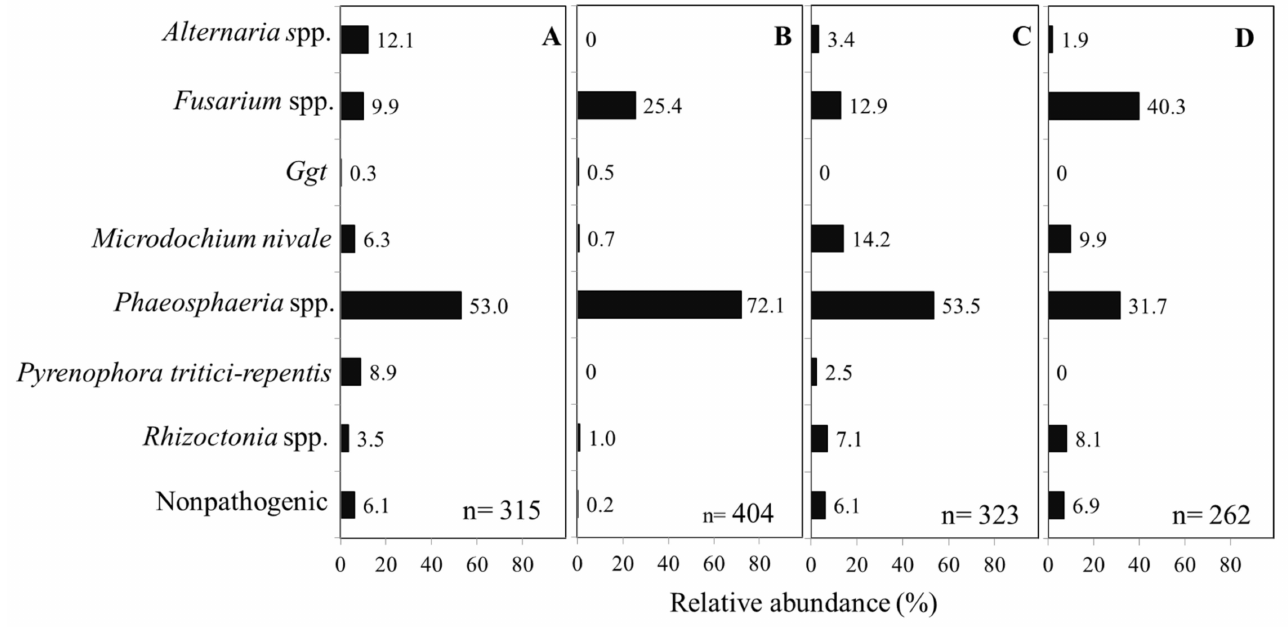
Figure 1. Relative abundance (%) of the fungal species isolated from the first internode of wheat culms on 20% acid PDA obtained from four intensively sampled fields in southern Chile during the grain-filling period: (( A ): Potrero 11-Perquenco, ( B ): El Ret é n-Osorno, ( C ): Potrero 13-Perquenco, and ( D ): Caj ó n-Temuco). N = total isolates obtained from 24 sampling points collected by field. In each sampling point, 20 culms were selected to be analyzed. A sampling point corresponded to 1 linear m of whole wheat plants, including tillers and roots up to 25 cm deep, collected from each field within an 800 m